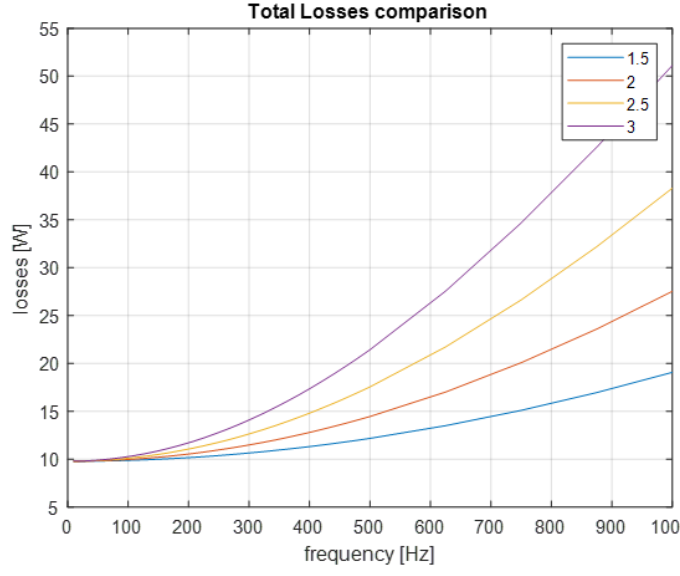
Figure 23. Total losses comparison—different